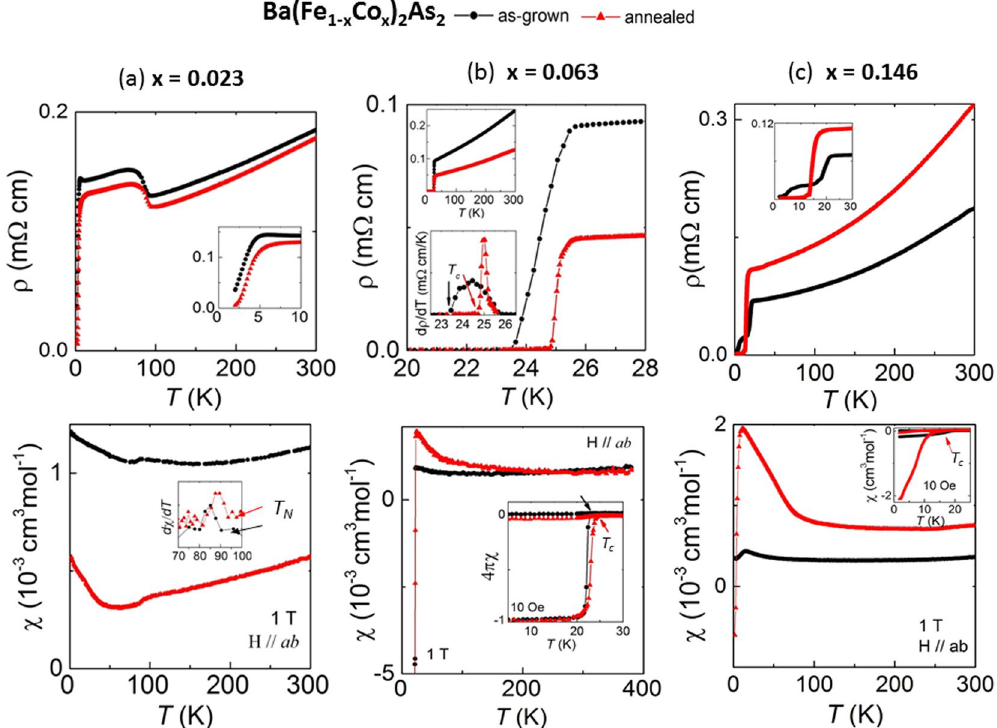
Figure 5. The improvement in superconducting critical temperature ( T c ) signals upon annealing Ba(Fe 1 − x Co x ) 2 As 2 crystals. For Ba(Fe 1 − x Co x ) 2 As 2 crystals of as-grown (in black) and annealed (in red), temperature dependence of resistivity ( ρ ; top row) and magnetic susceptibility ( χ ; bottom row) for ( a ) x = 0.023, ( b ) x = 0.063, and ( c ) x =